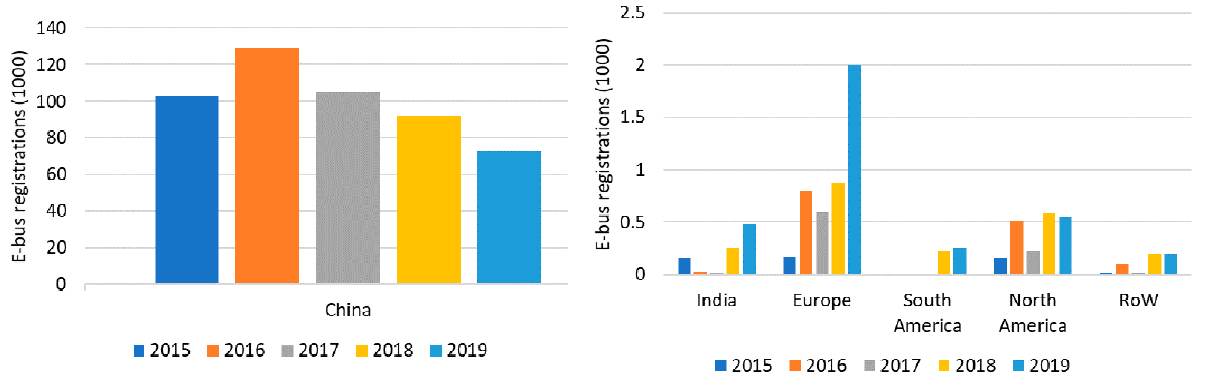
Figure 9. New e-bus registrations by country/region, 2015–2019 (Data source: [47]).